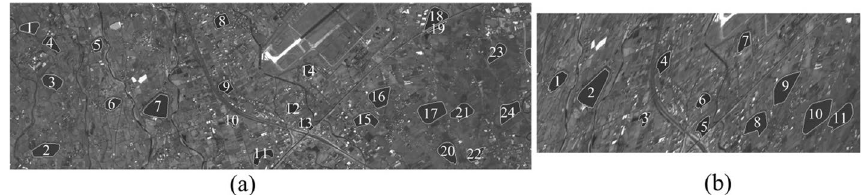
Fig. 6 Real data taken over areas of Taipei by different